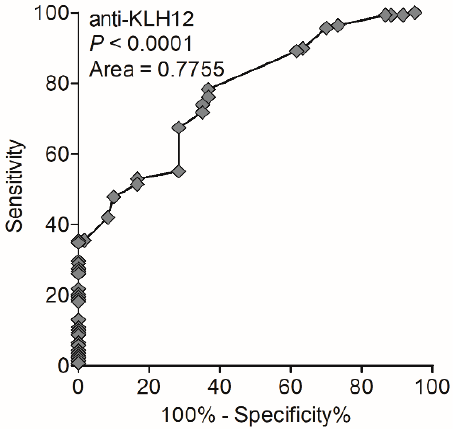
Figure 5. Receiver operating characteristic curve analysis for serological detection of anti-KLHL12 autoantibodies in PBC patients.